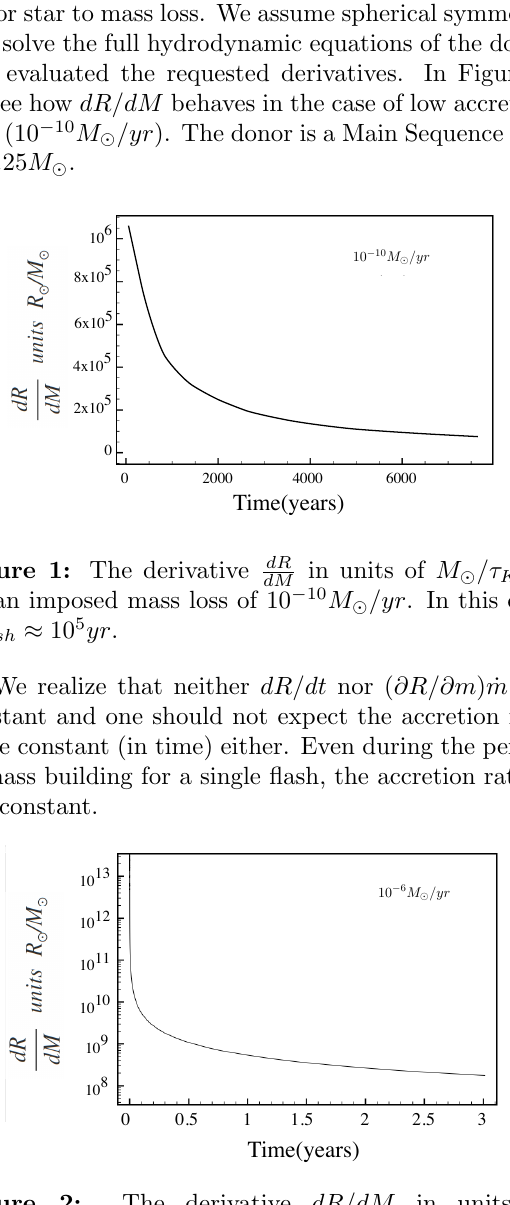
Figure 2: The derivative dR/dM in units of M (cid:12) /τ KHR for an imposed mass loss of 10 − 6 M (cid:12) /yr . In this case τ flash 10 yr ≈